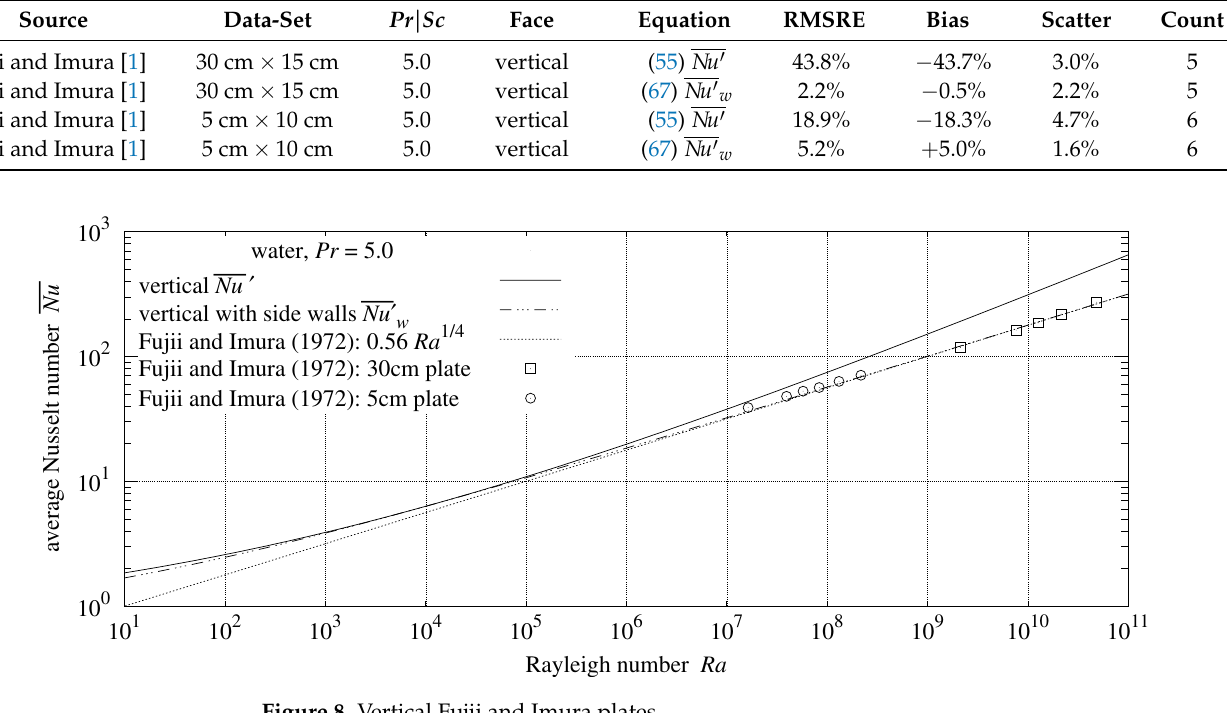
Figure 8. Vertical Fujii and Imura